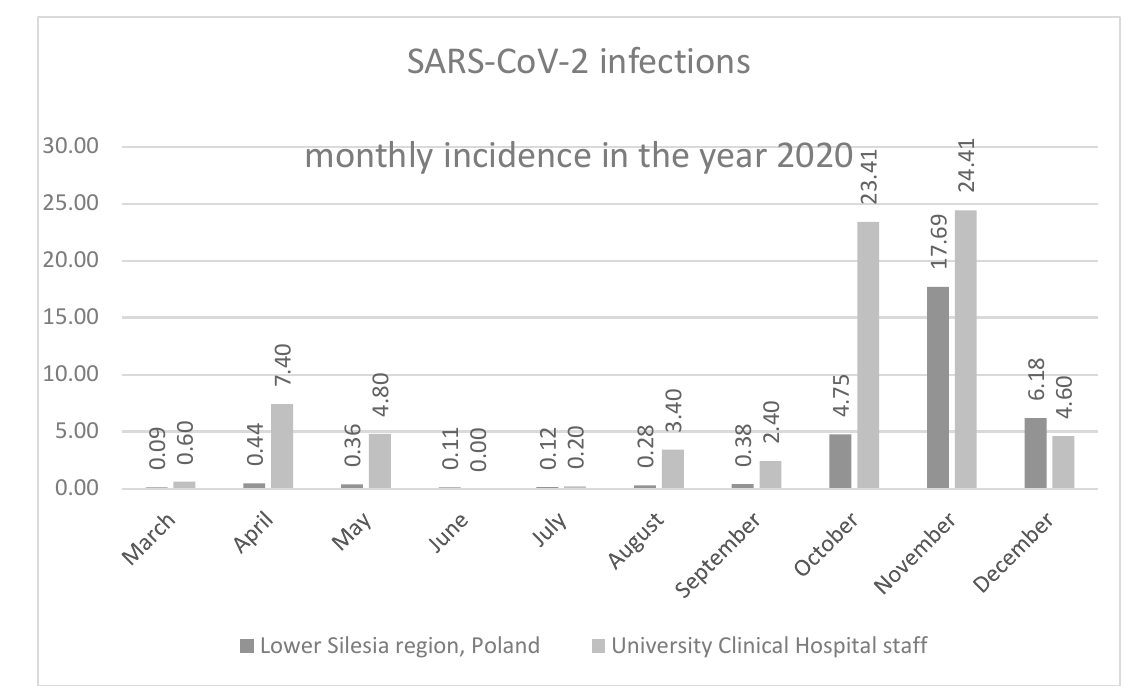
Figure 1. Monthly incidence of new SARS-CoV-2 infections among the Lower Silesia region population and among the University Clinical Hospital in Wroc ł aw staff in the year 2020, per 1000 population.